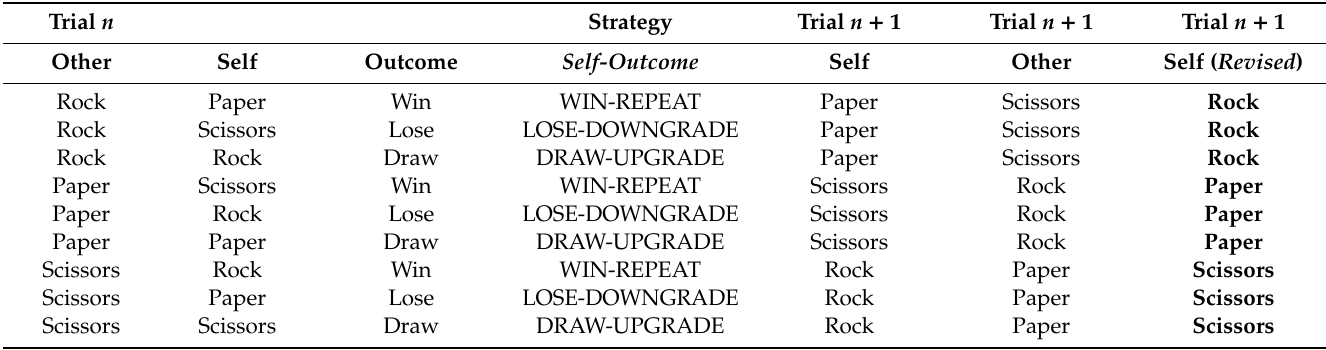
Table 2. Logic of a second-order self-outcome